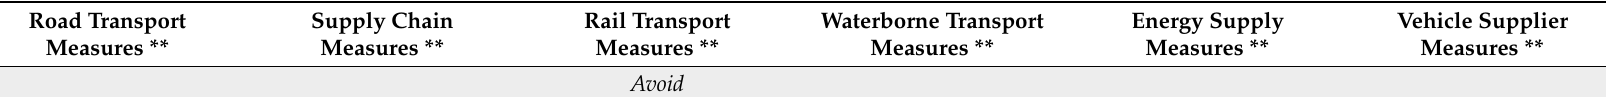
Table 4. Identified International Sustainable Freight Transport